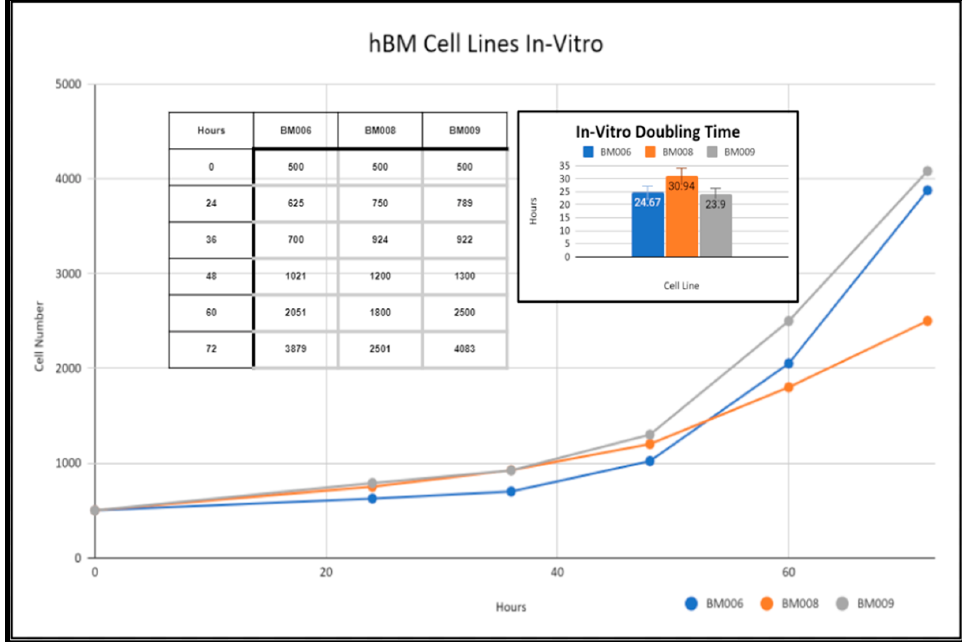
Figure 3. In vitro growth rates of primary hBM adherent cell cultures.